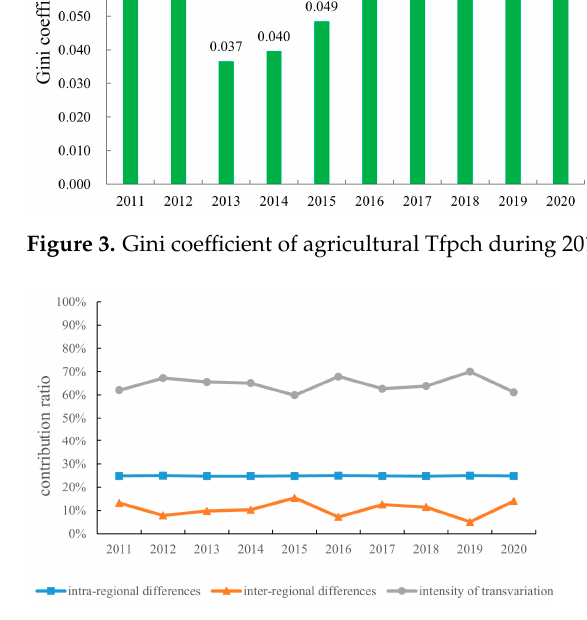
Figure 4. Decomposition contribution ratio of Gini coefficient of agricultural Tfpch during 2011–2020.